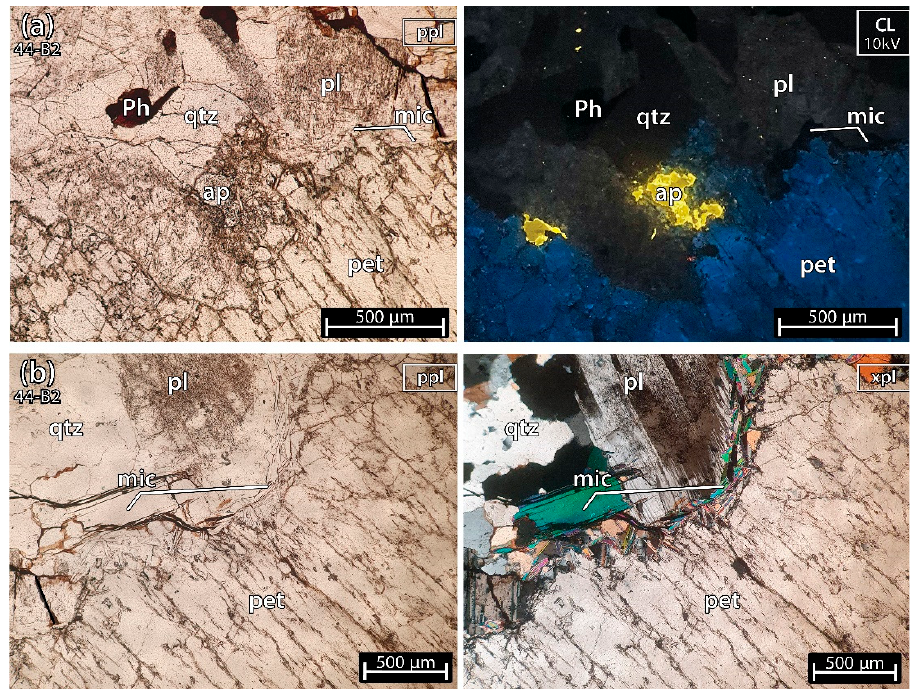
Figure 8. Microphotographs in parallel polarized light (ppl), crossed polarized light (xpl) and cold cathodoluminescence (CL) microscopy from a petalite (pet) fragment of the crystal sample 2 of the aplite-pegmatite 44 (44-B2), also known as Antigo. This sample contains a great amount of other minerals such as: ( a ) plagioclases (pl), quar tz (q tz ), Fe-Mn phosphates (Ph) and apatites (ap); ( b ) , white micas (mic), plagioclases (pl), quar tz (q tz ). The crystals of petalite did not host any spodumene or quar tz , and had some micas